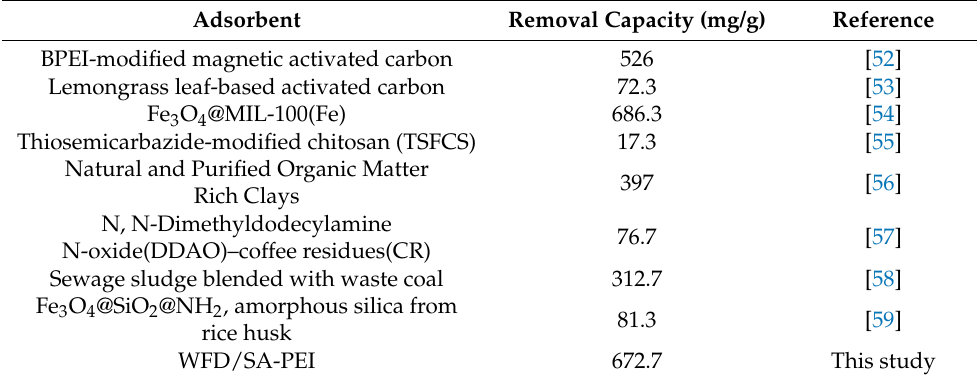
Table 6. MR removal capacities of various low-cost adsorbents reported in the